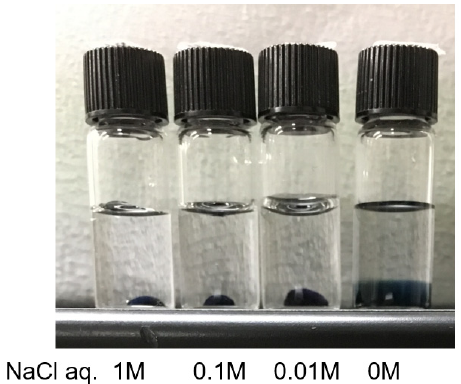
Figure 6. Solubility test of the hydrogels using a lump of the NaPPDT / PAPA 1/1 ( w / w ) composite hydrogel in NaCl aq. after 1 week.